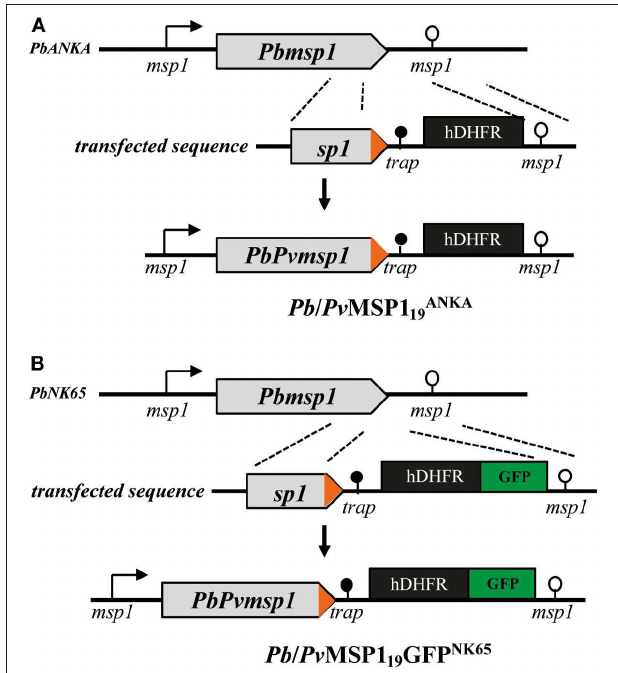
FIGURE 1 | Strategy for generating the modified MSP1 locus. Modification of the MSP1 locus in P. berghei ANKA ( Pb ANKA) (A) and in P. berghei NK65 ( Pb NK65) (B) for the generation of the Pb/Pv MSP1 ANKA 19 and of the Pb/Pv MSP1 19 GFP NK65 hybrid parasites, respectively. Arrow boxes, coding sequences; arrows, 5 ′ UTR; open circle lollipop, 3 ′ UTR of msp1 ; black circle lollipop, trap 3 ′ UTR; black box, hDHFR selection marker cassette; green box, GFP cassette. P. berghei sequences are in gray and P. vivax sequences in